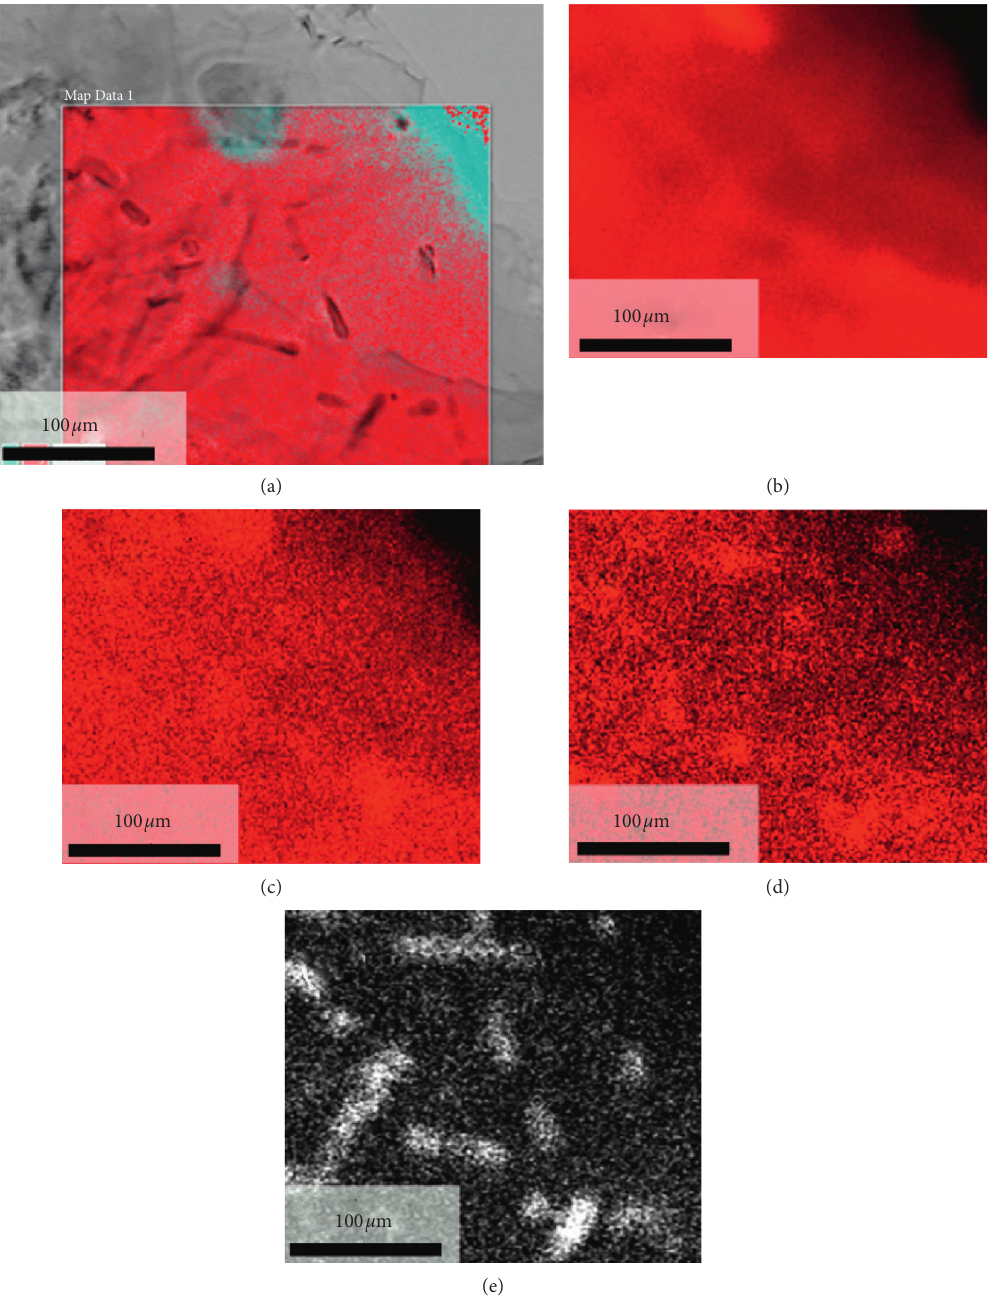
Figure 12: The EDS mapping of the alloy with a rolling temperature of 400 ° C. (a) Selected region from TEM bright field image, (b) Mg element, (c) Al element, (d) Zn element, and (e) Sn